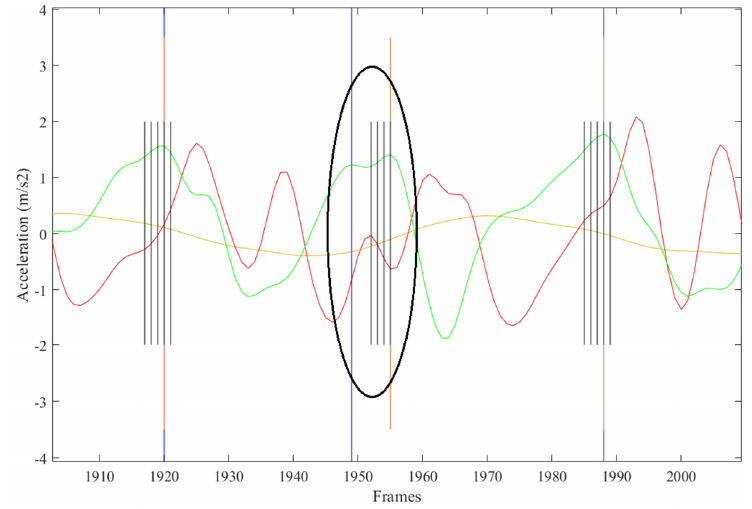
Figure 5. Automated FS inserted more than five frames from manually labelled FS.